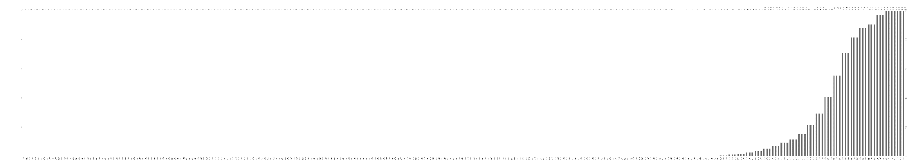
Figure 17. The null values in the